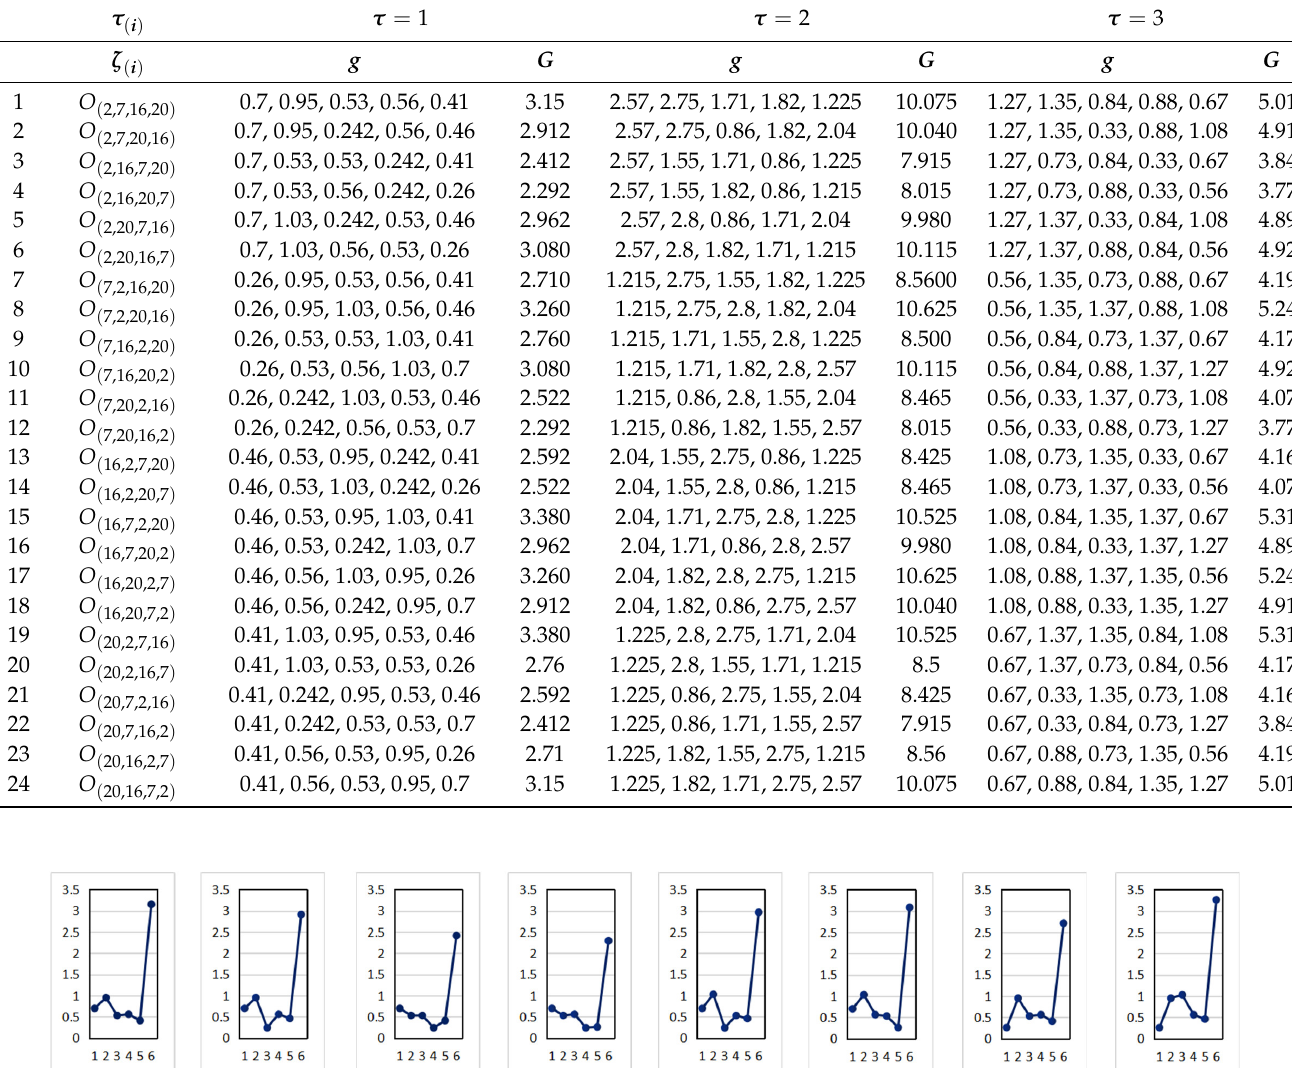
Table 6. Tour route section weight and global weight iteration value in different transportation modes.